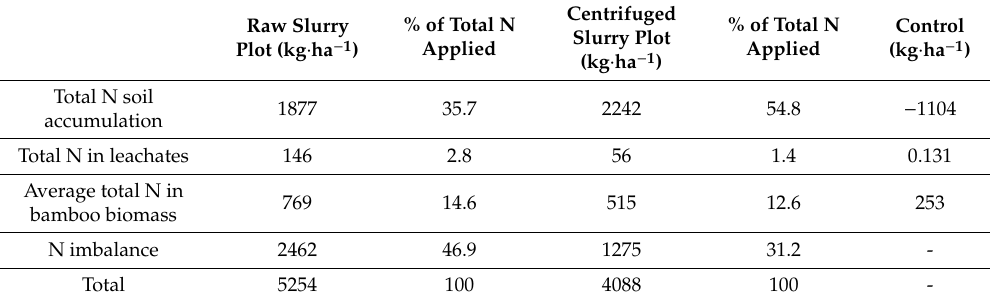
Table 4. Nitrogen balance between the bamboo biomass, soil and leachates.